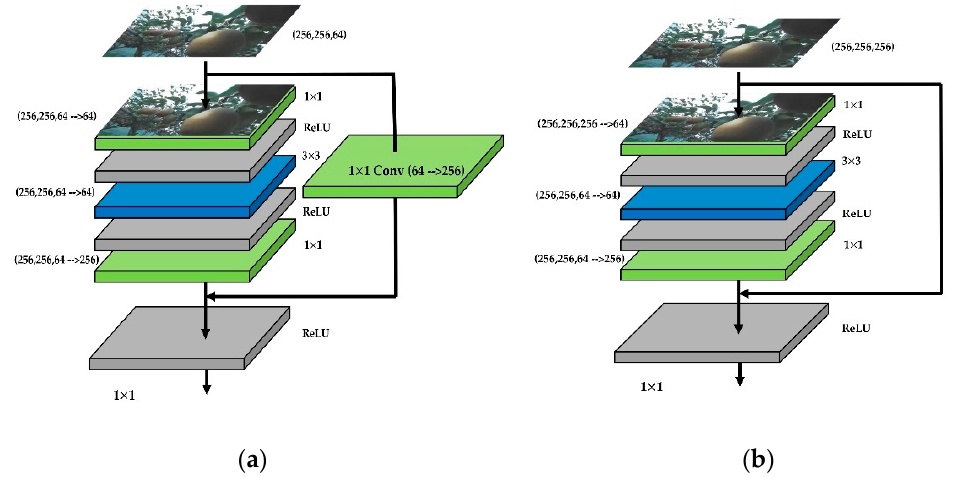
Figure 4. The inner structure of ResNet101 as an example of second layers (C2): ( a ) is conv block and ( b ) is identity block. The images which were inputted into the ResNet have changed the channels. Conv block is the first stage of each layer, and the identity blocks and conv blocks were combined to the ResNet.